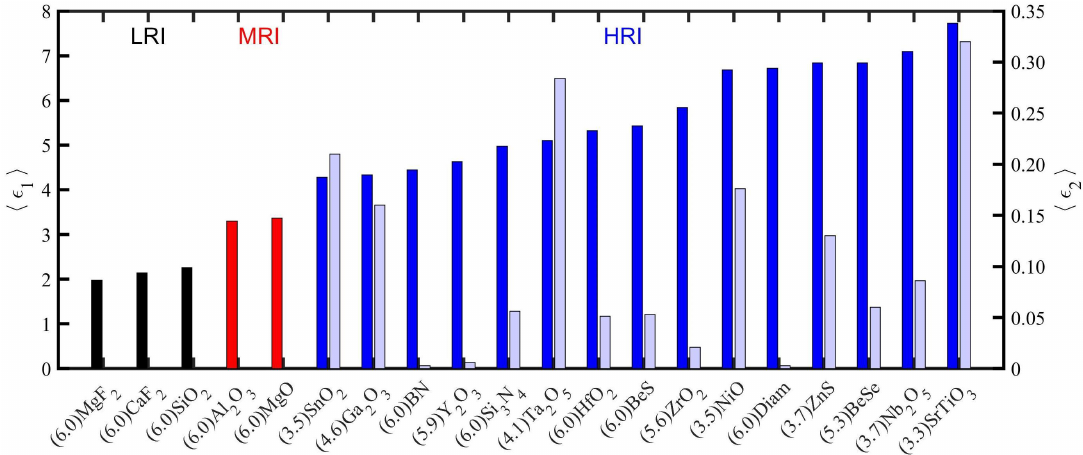
Figure 2. Mean real part (left axis) and mean imaginary part (right axis) of the permittivity calculated from 3 eV to the energy indicated between parenthesis below the compound label (x-axis) of all the 20 materials studied in this